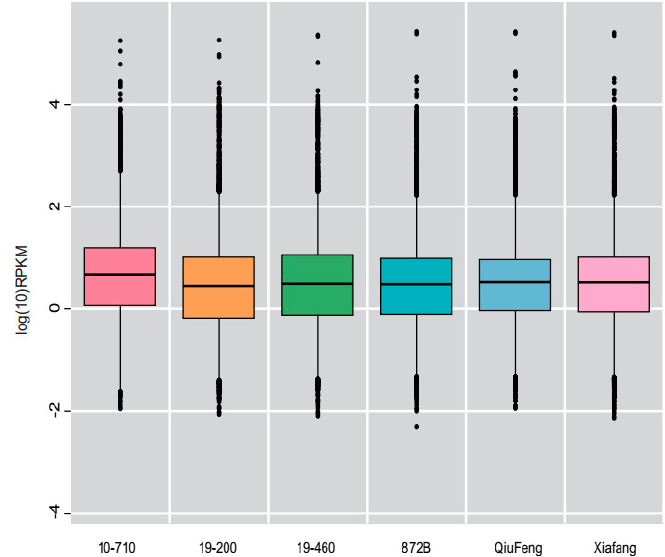
Figure 1. Phenotyping survey of silkworm cocoons. 19-460, 10-710, and 19-200 are low-yield strains of the silkworm. 872B, Qiufeng, and Xiafang are high-yield strains of the silkworm. t -Test between high-yield and low-yield strains, ***: p ≤ 0.001. Table 1. Statistical analysis of yield-related traits in various silkworm strains.